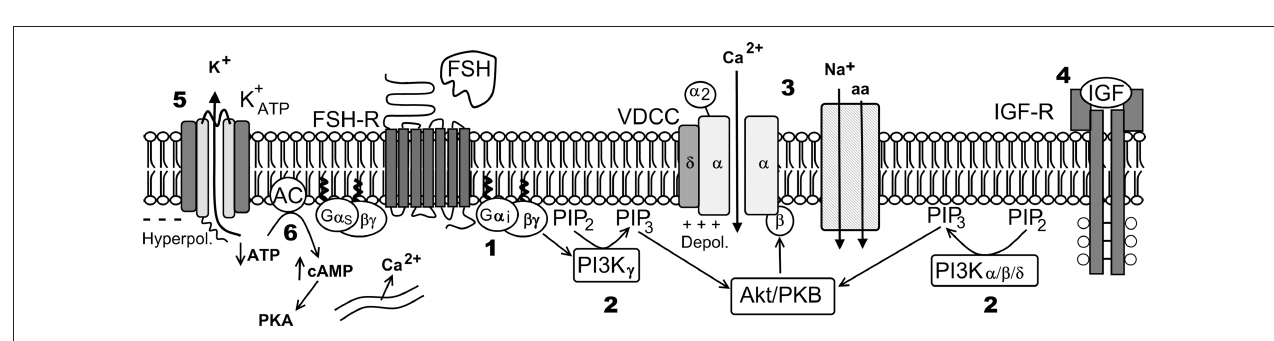
the effect of FSH (D) . Sertoli cells were pre-incubated with anti-IGF-I antibody for 1 h before IGF-I or FSH application. (A) ** p < 0.001; n = 5 in each treatment (IGF-I or IGF-I plus anti-IGF-I) from five separated experiments; (C) * p < 0.05; n = 5 or in brackets, one separated experiments for each concentration; (D) * p < 0.05; n in brackets, two separated experiments for each